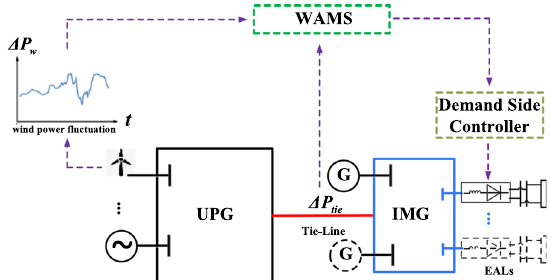
Fig. 2 The wide area closed-loop demand side control architecture with the application of WAMS